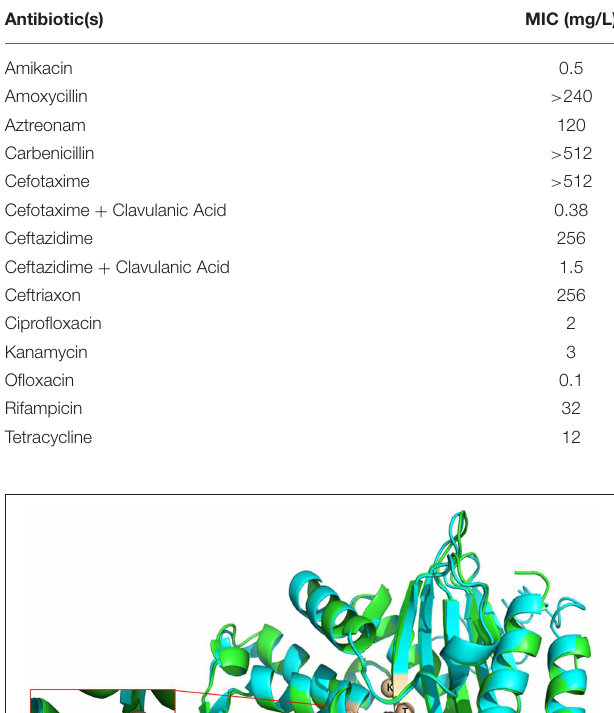
TABLE 3 | MIC values corresponding to different antibiotics for K. georgiana MRB7 isolate.